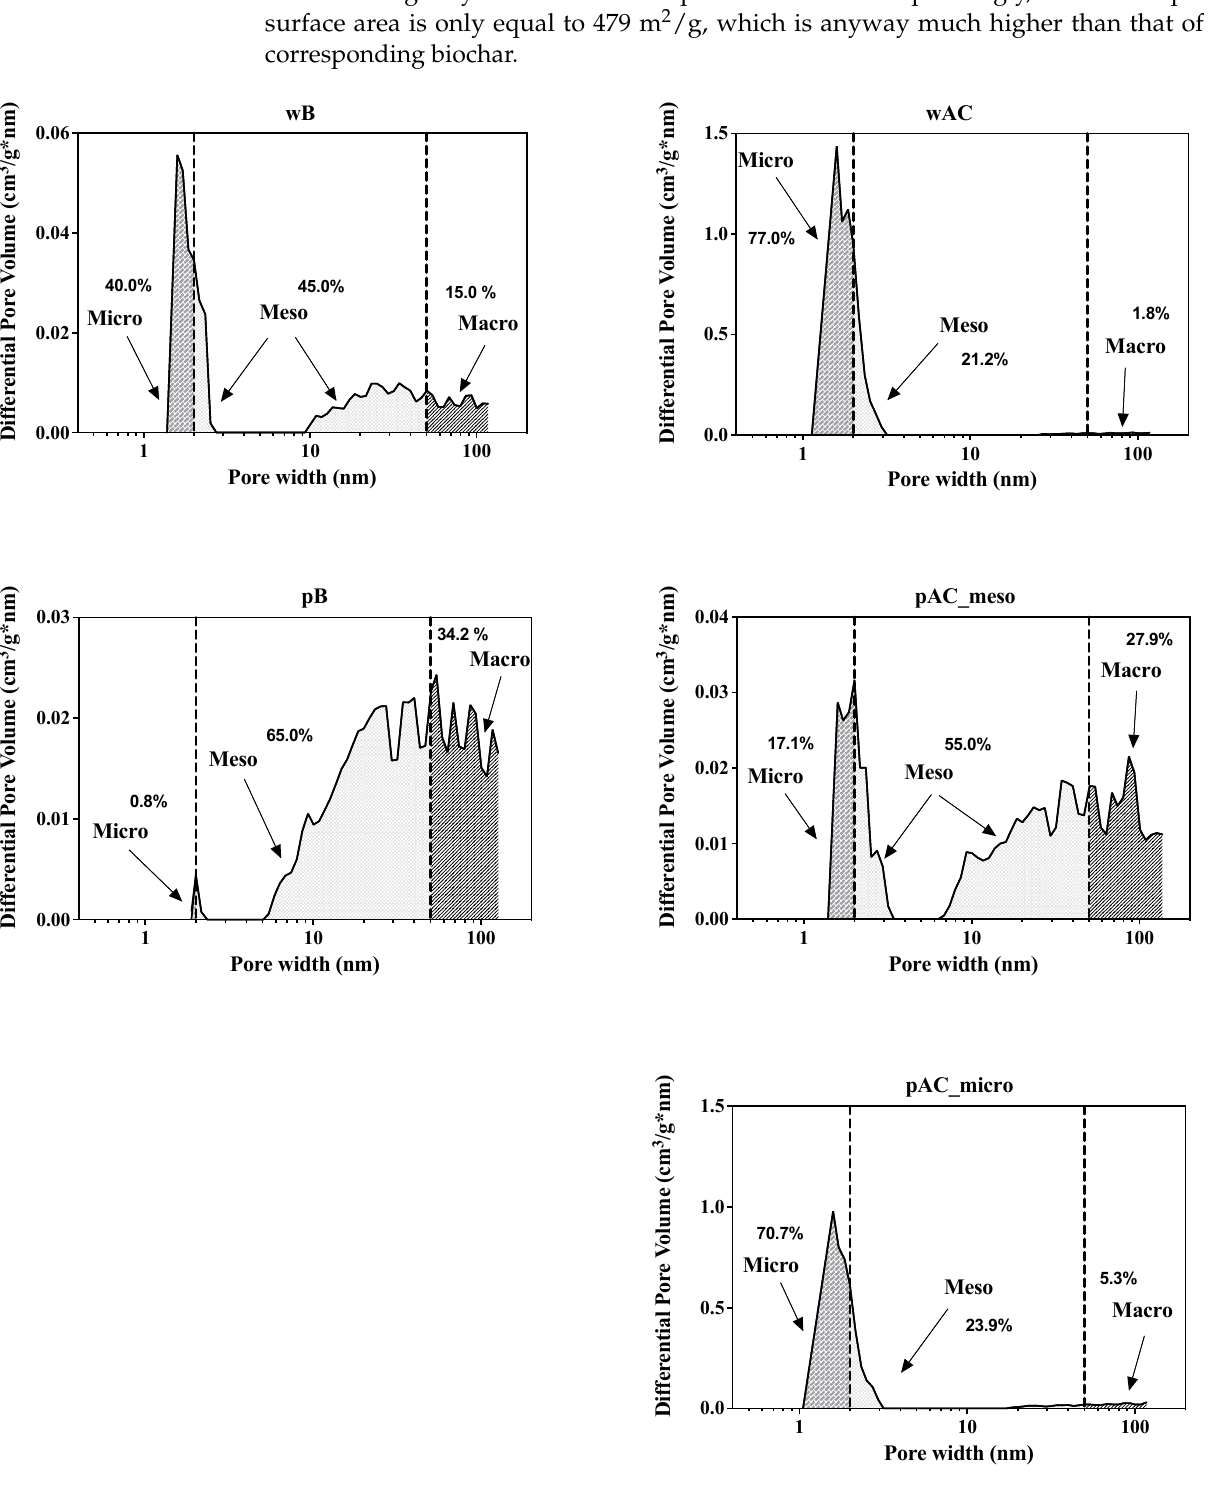
Figure 2. Pore size distribution of the biochars and activated carbons.